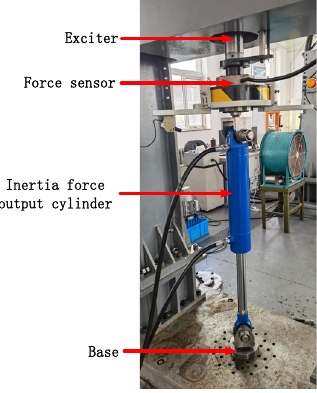
Figure 11. Prototype of dual-cylinder fluid inerter.